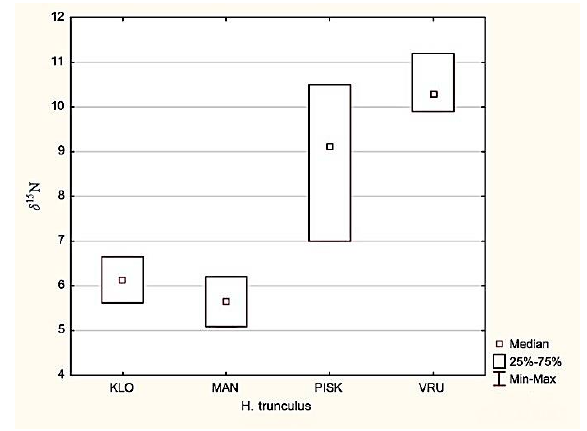
Figure 4. Box-plot diagram of the δ 15 N values of H. trunculus.